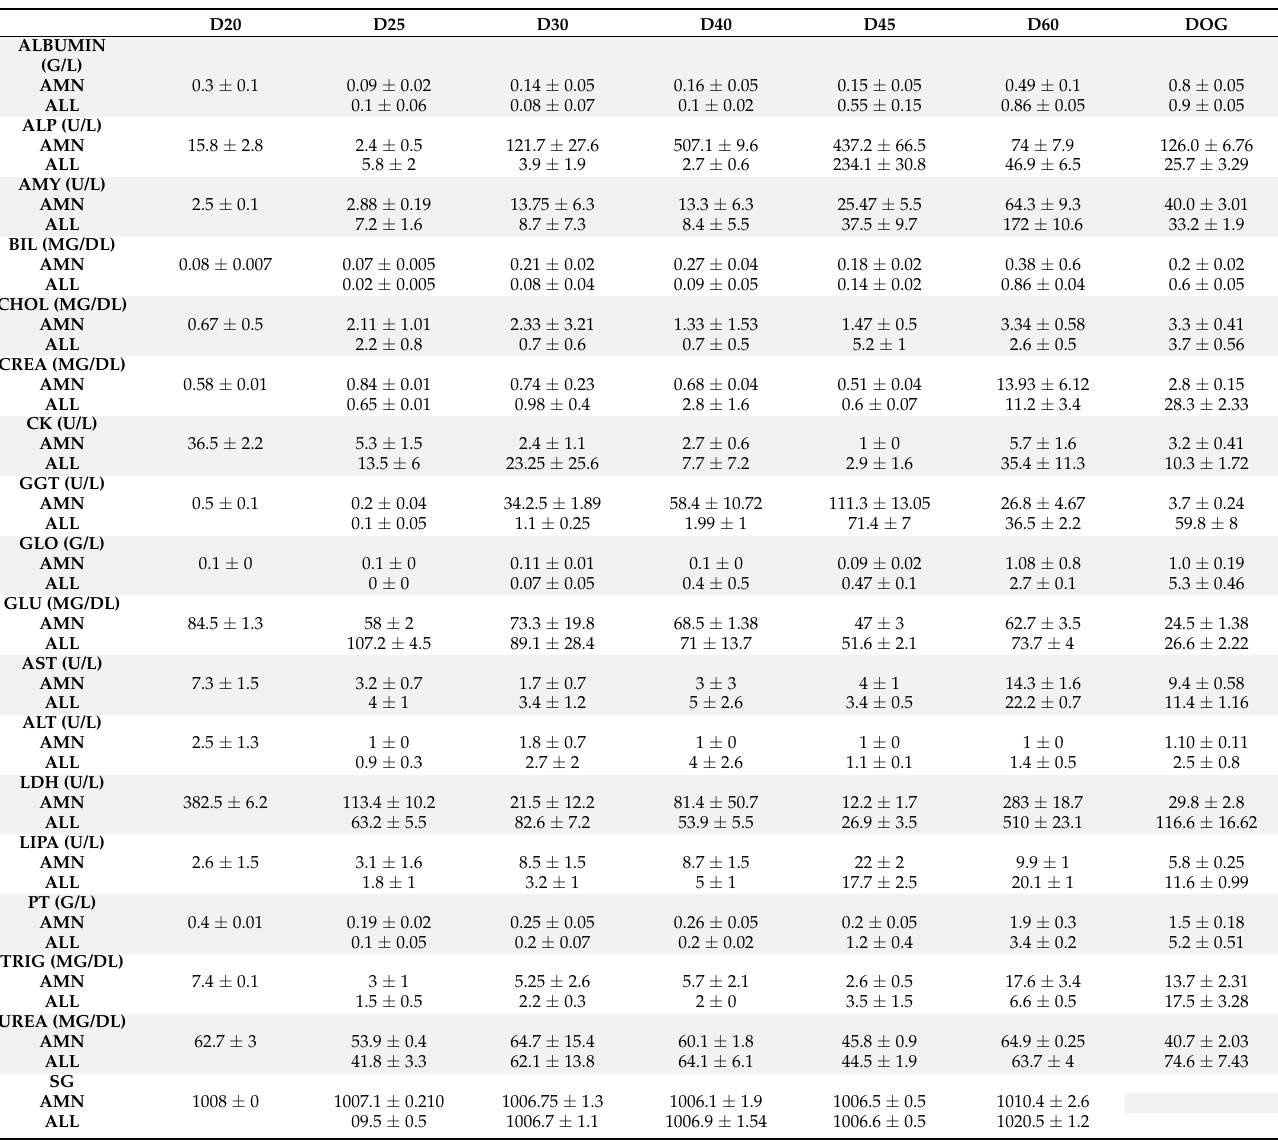
Table 1. Concentration of biochemical components throughout pregnancy in amniotic fluid (AMN) and allantoic fluid (ALL). Values are expressed as mean ± SE. Number of samples: D 20 , AMN = 7, ALL = 0; D 25 , AMN = 7, ALL = 7; D 30 , AMN = 7, ALL = 7; D 40 , AMN = 7, ALL = 7; D 45 , AMN = 8, ALL = 8; D 60 , AMN = 8, ALL = 8. A comparison with physiological at-term pregnancies in dogs is performed (data depicted by Veronesi et al. [10]), data are represented in the “DOG”